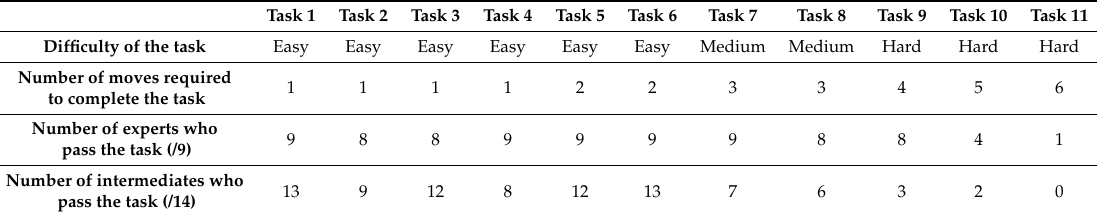
Table 2. Experts and Intermediates results summary for N-Check-Mate tasks. The number of moves required to complete the task is also given. The higher the number of moves needed, the higher the difficulty.